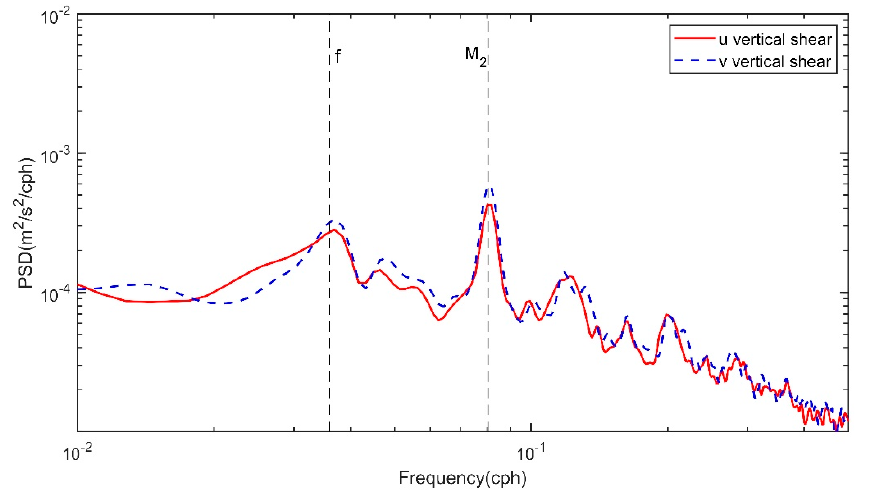
Figure 16. Depth-averaged (from 50 to 540 m) power spectra of the shear of zonal (red solid line) and meridional (blue dashed line) residual currents. The black dashed lines denote the local inertial frequency f and the frequency of the M 2 internal tide.